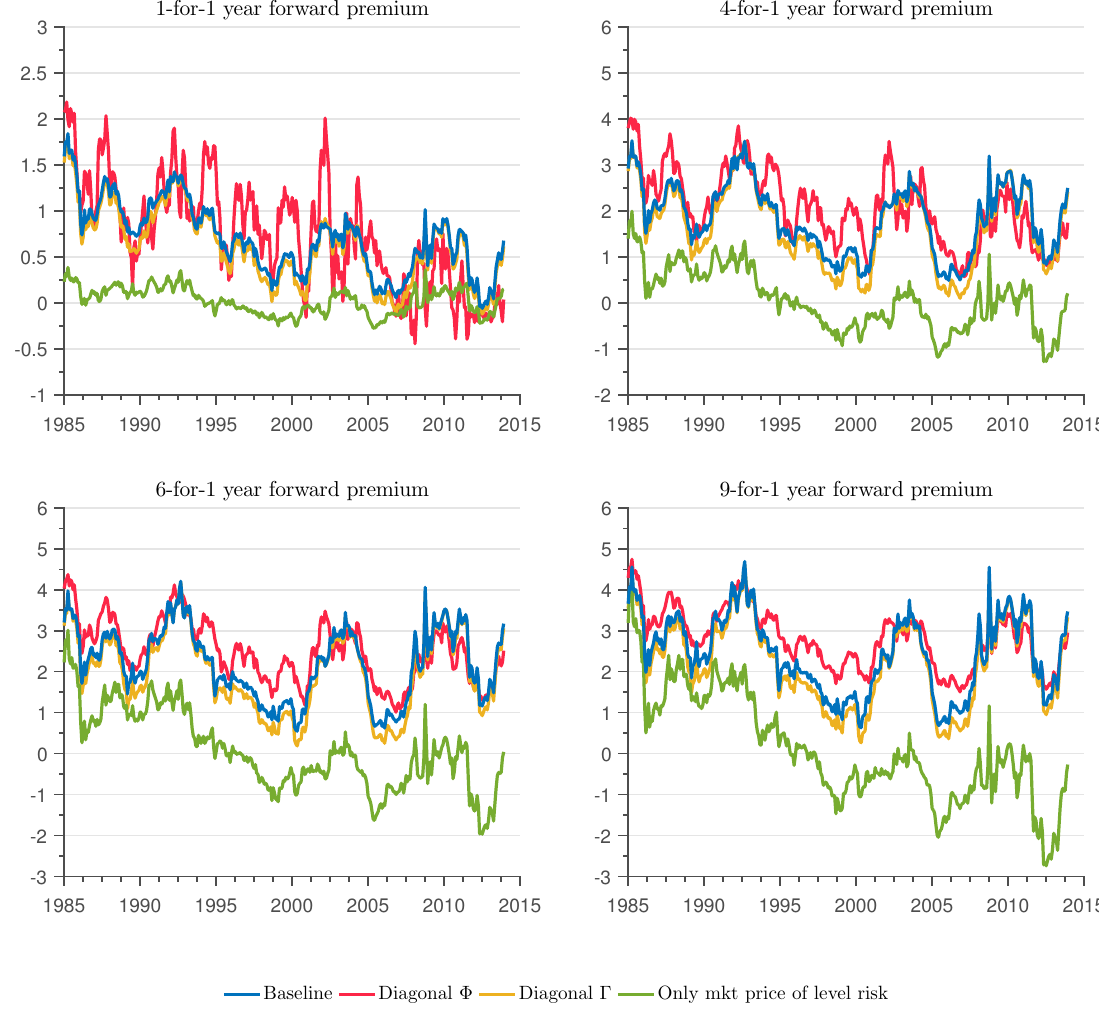
Figure 2. Forward premium: different models and